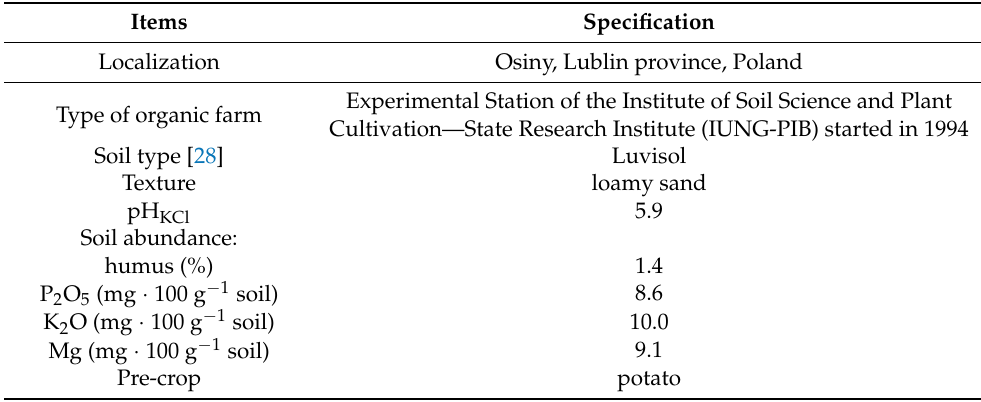
Table 1. The characteristics of habitat conditions of the experiment. Items